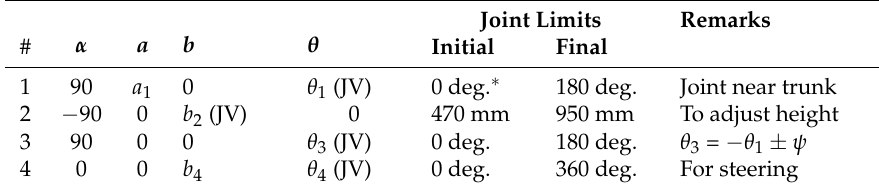
Table 2. Denavit and Hartenberg (DH) parameters of the single leg of Tarantula